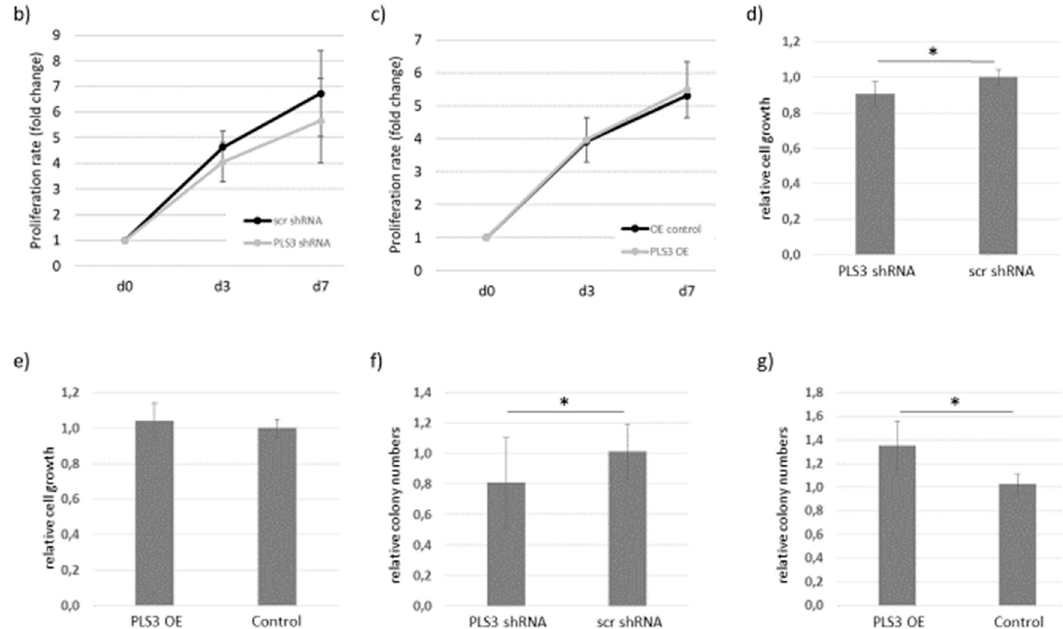
Figure 2. Functional in vitro assays with PLS3 knockdown and overexpression Kasumi-1 cells. ( a ) GFP PLS3 overexpression cells were used to study the co-localization of PLS3 and F-actin. F-actin was labeled with Alex-fluor568-conjugated phalloidin (red). ( b – e ) Proliferation of PLS3-knockdown ( b , d ) and PLS3-overexpression ( c , e ) Kasumi-1 cells were analyzed in proliferation assays over 7 days. ( b ) and ( c ) show a growth curve over 7 days, ( d ) and ( e ) show the bar graphs of the relative cell growth on day 7. ( f , g ) The colony formation capacity of PLS3-knockdown ( f ) and PLS3-overexpression ( g ) Kasumi-1 cells were analyzed in colony formation assays over 7 days. * p < 0.05.